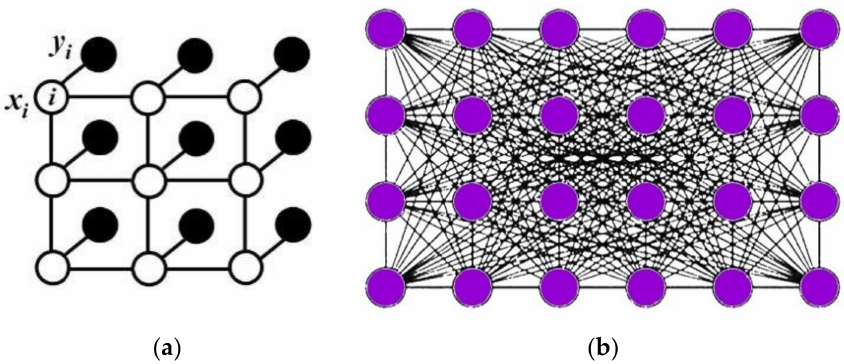
Figure 14. Schematic diagram of ( a ) CRF and ( b ) fully connected CRF.